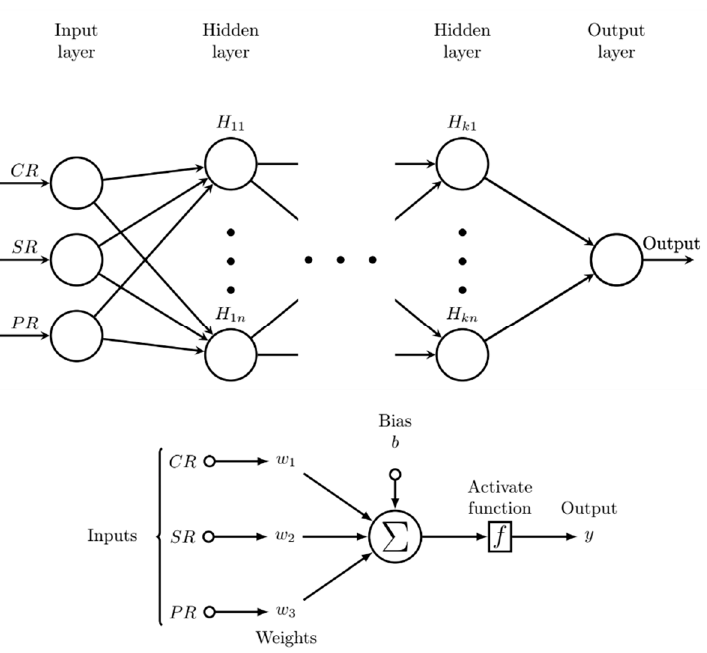
Figure 1. Upper figure: fully connected feed-forward artificial neural network (CR = Current ratio; SR = Solvency ratio; PR = Profitability ratio); lower figure: schematic of the computational unit (artificial neuron) of the network.